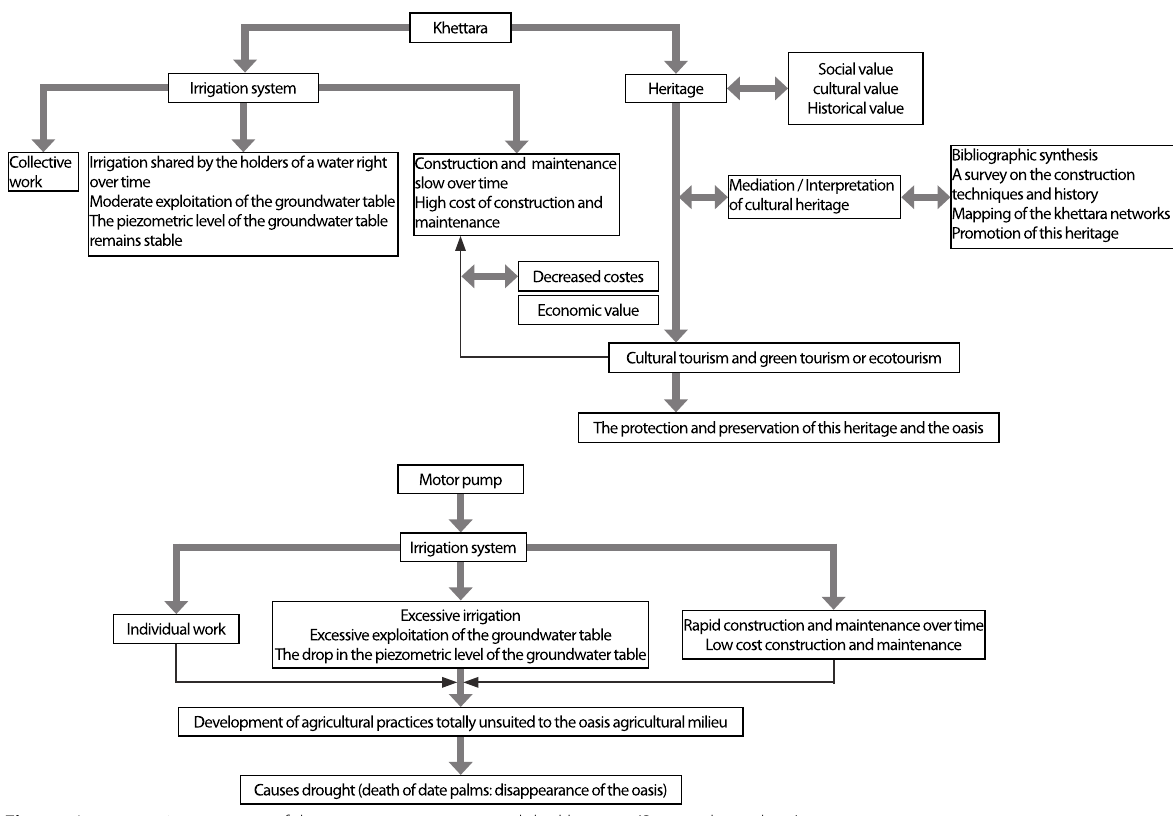
Fig. 11 A comparative summary of the motor pump system and the khettaras (Source: the